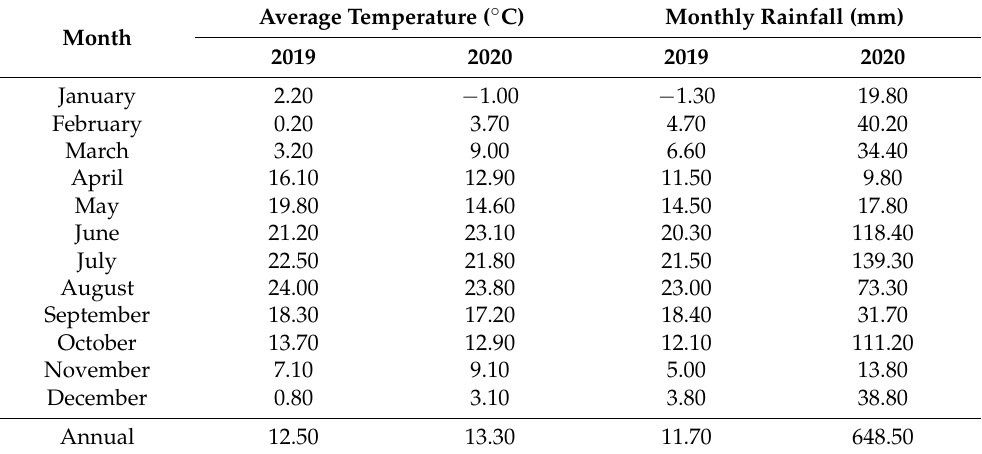
Table 1. Average temperature and precipitation (Karcag) in the period under review (2019–2020). Average Temperature ( ◦ C) Monthly Rainfall Month